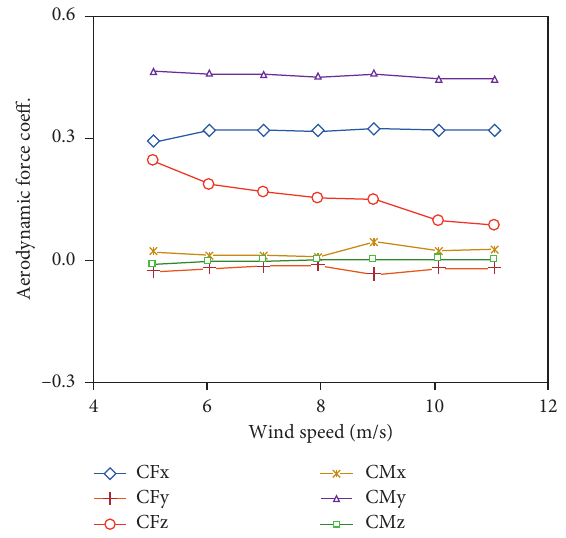
Figure 8: Reynolds number dependence of aerodynamic forces acting on the tower observatory.